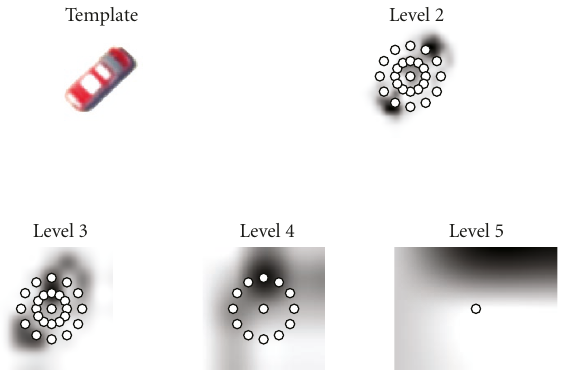
Figure 3: Magnitude of the template DTCWT coe ffi cients. The white dots indicate the locations of the coe ffi cients that are used in the P -matrix template. Four di ff erent scales, or levels, are used. Only one of the 6 subbands is